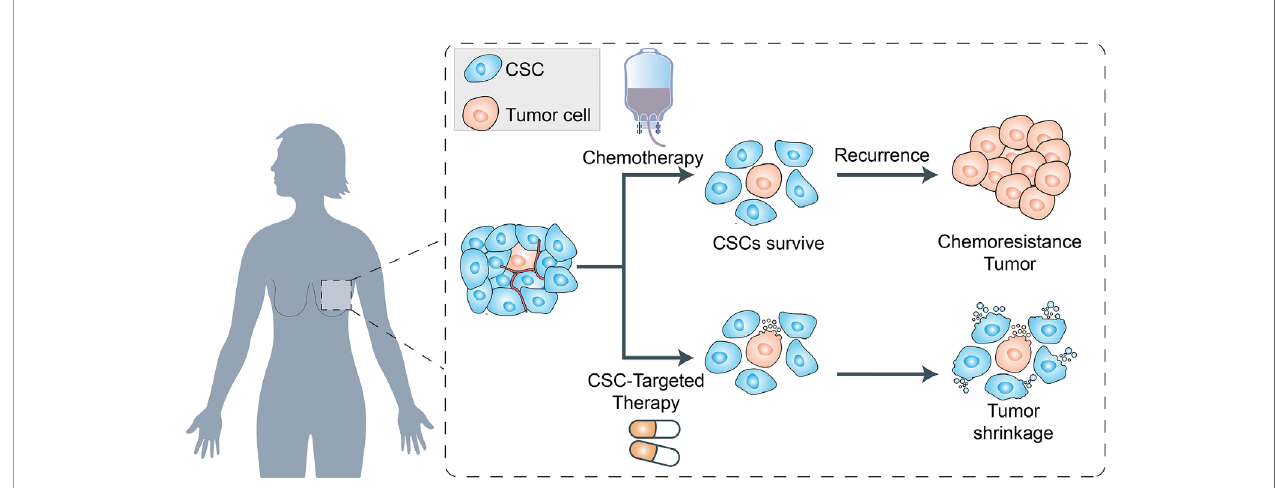
FIGURE 3 | Schematic representation of cancer stem cells (CSCs) and their role in chemoresistance. The cancer stem cells (CSCs), not only enable tumor formation and progression but also mediate tumor metastasis and therapeutic resistance. On the one hand, the CSCs survived from chemotherapy will gain the chemoresistance and enhance the key processes involved in cancer progression. On the other hand, the cancer therapeutics targeted to CSCs biomarkers which can modulate EMT and CSC properties, can lead to the tumor shrinkage in clinical